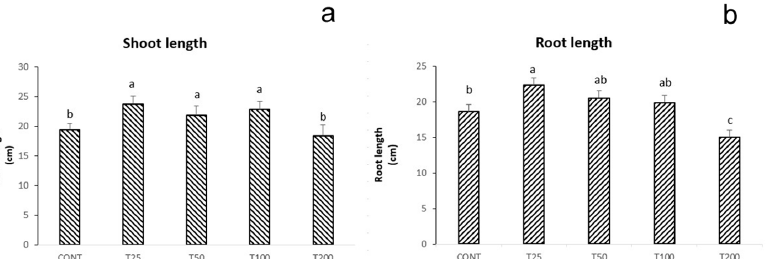
decreased root length.